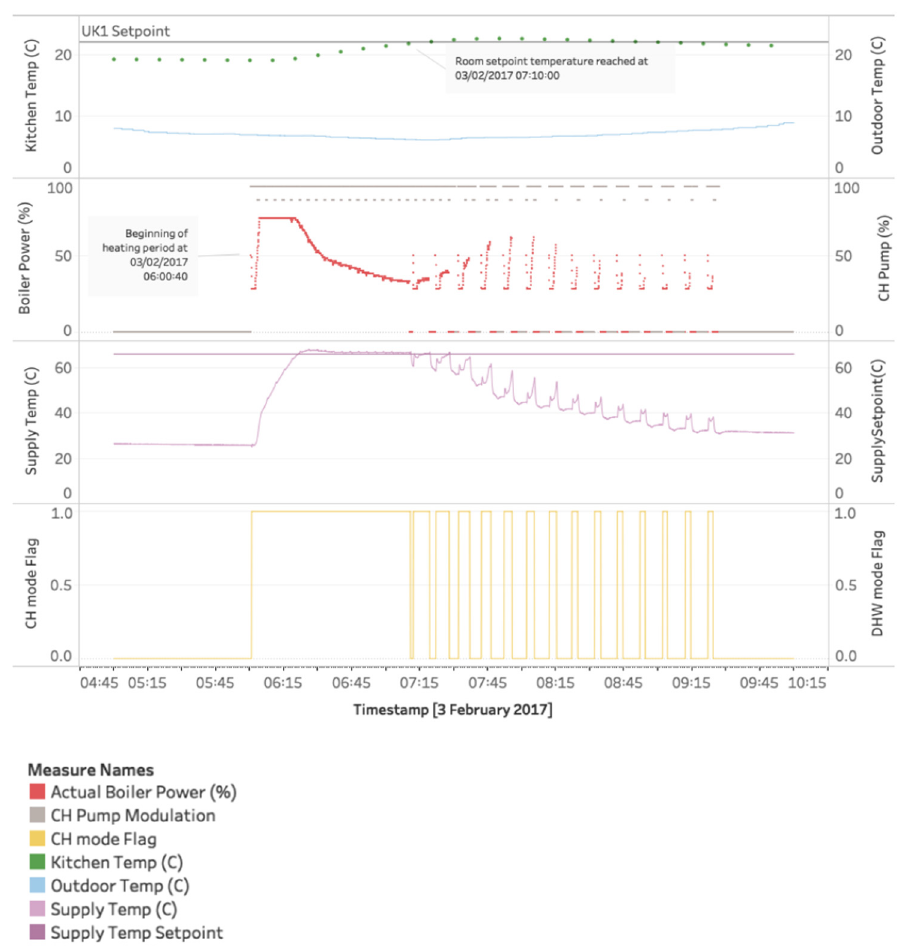
Figure 1. Example timeseries data from OXF1 dwelling.